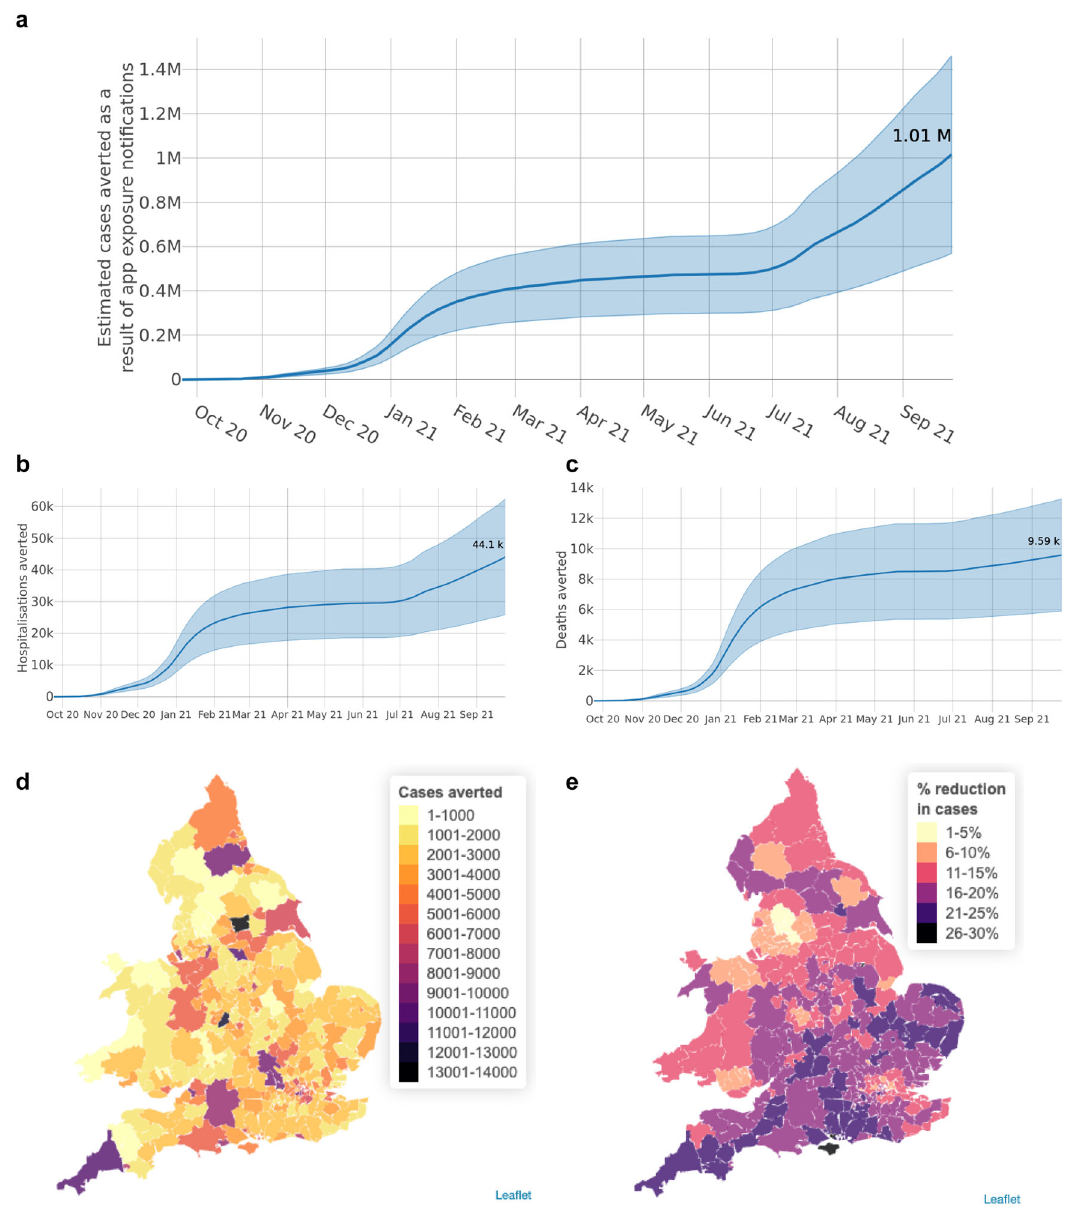
Fig. 6 | Epidemiological impacts. Cumulative estimated numbers of a cases, b hospitalisations and c deaths averted by app exposure noti fi cations between 24 September2020and24September2021.Shadinginpanels a – c indicatestherange of outcomes between upper and lower plausible estimates of an individual ’